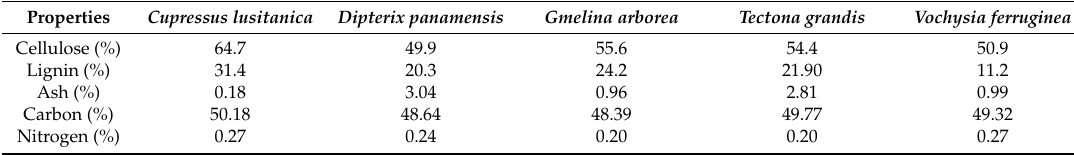
Table 1. Chemical composition of five fast-growth plantation species in Costa Rica.